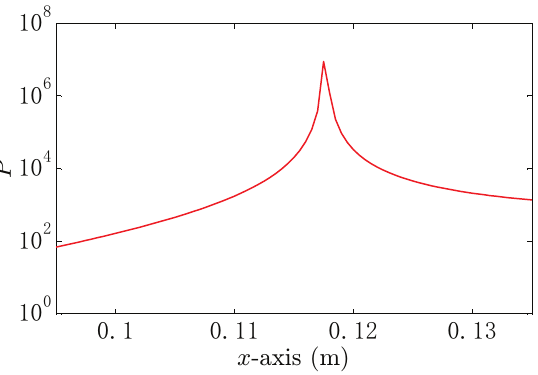
Figure 19. The space spectrum of the electro-locator at the hypothesis point ( x ,0,0.07 ) .